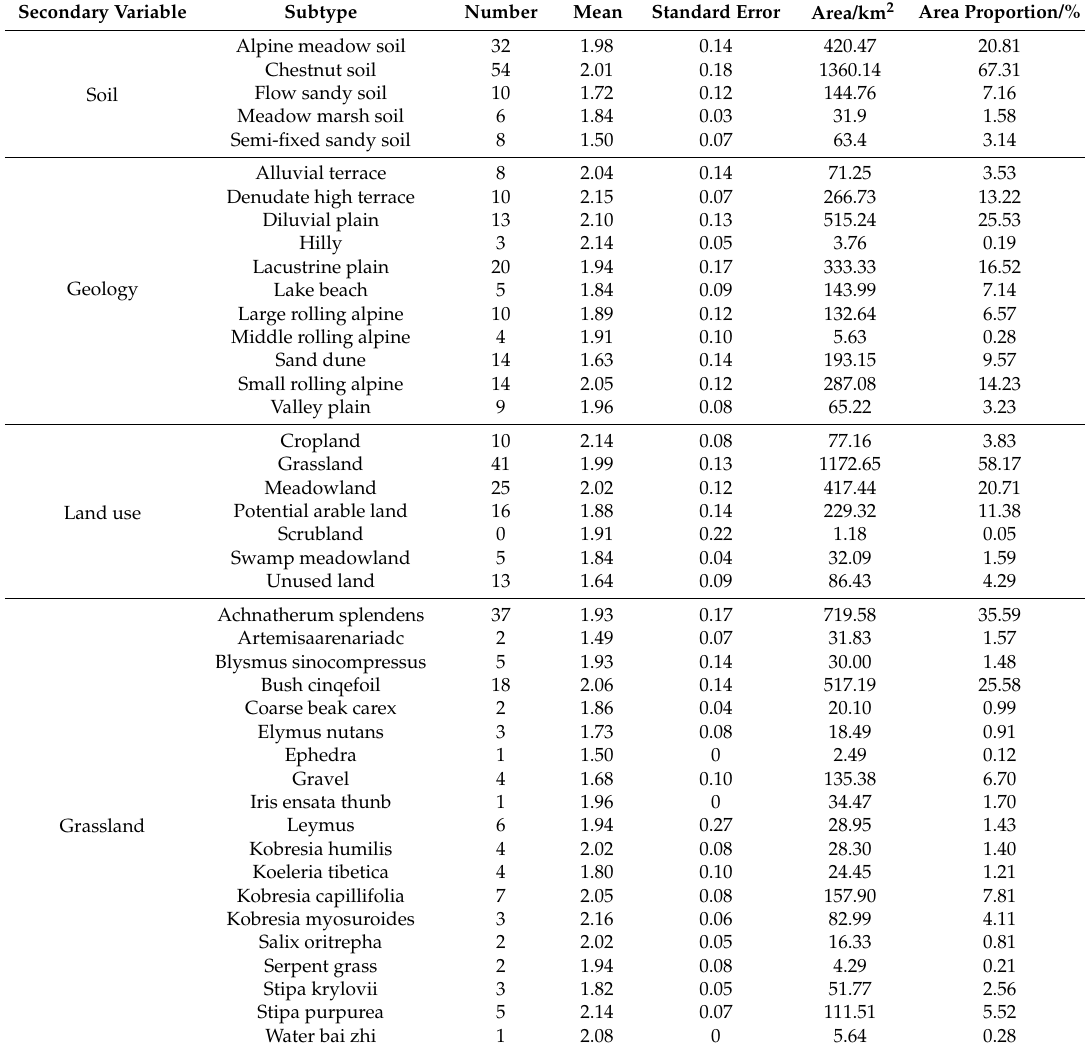
Table 1. Descriptive statistical characteristics of soil K + content in different secondary